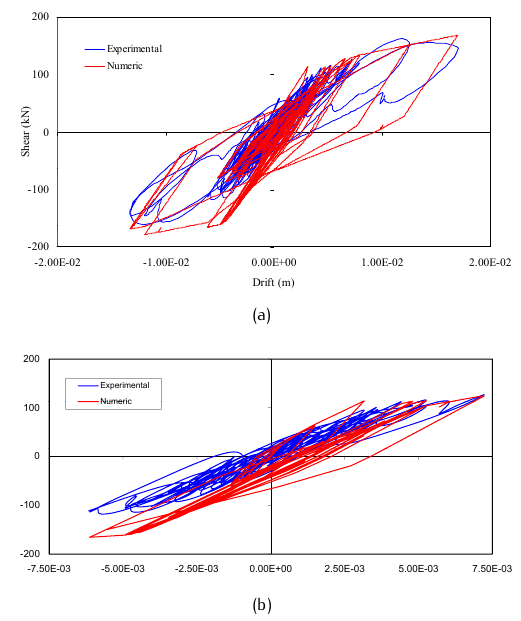
Figure 15. Column shear-drift results considering bending and shear behaviour: (a) complete test; (b)